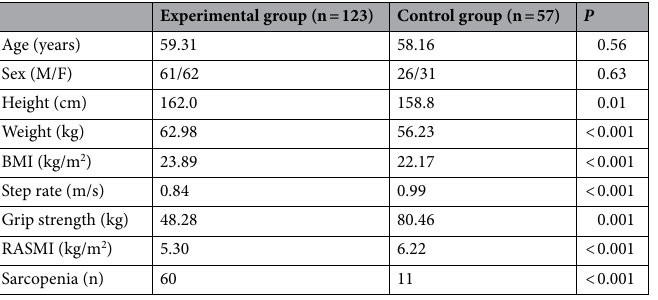
Table 1. Comparison of the general characteristics between the experimental group and control group. BMI body mass index, RASMI relative appendicular skeletal muscle index.